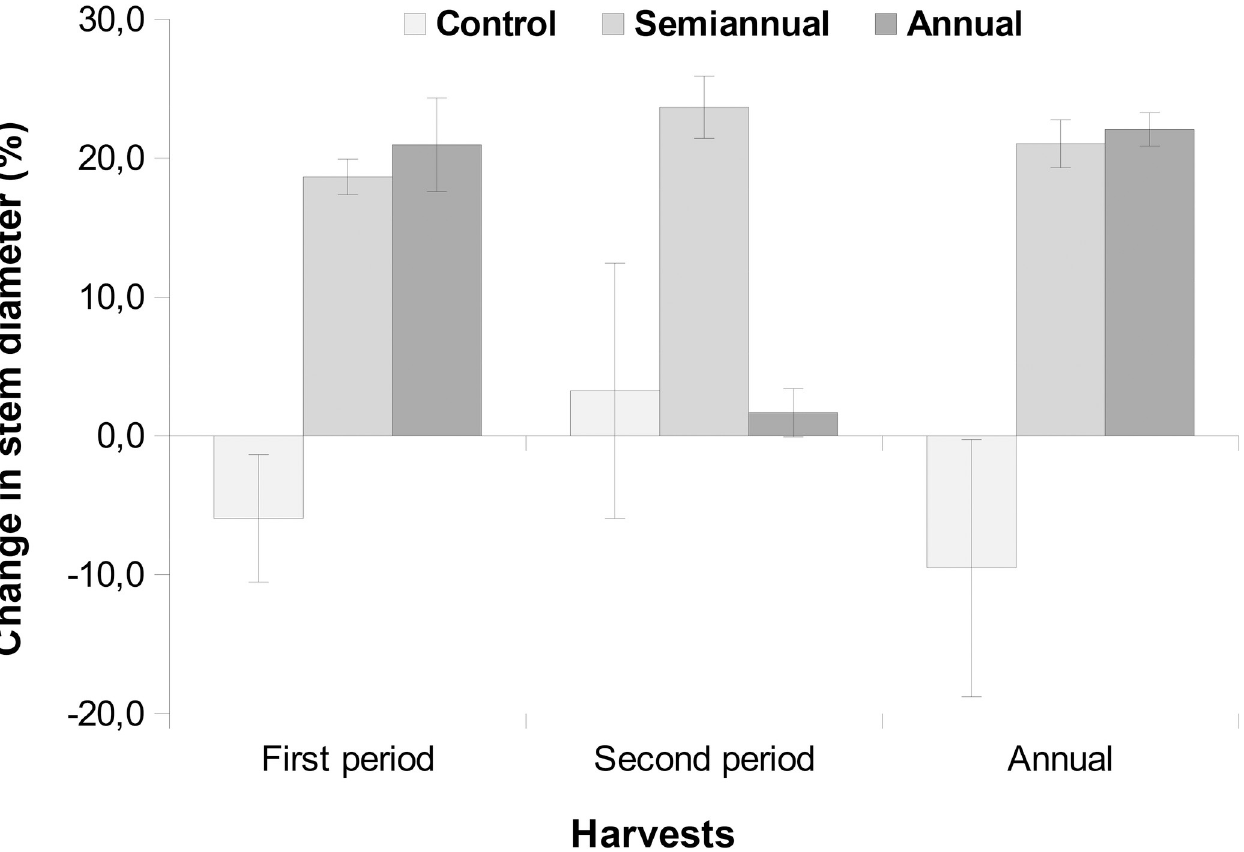
Fig 3. Change in mean ( ± standard error) stem diameter of Forsteronia glabrescens surviving after six months and one year of harvesting and unharvested, control group.